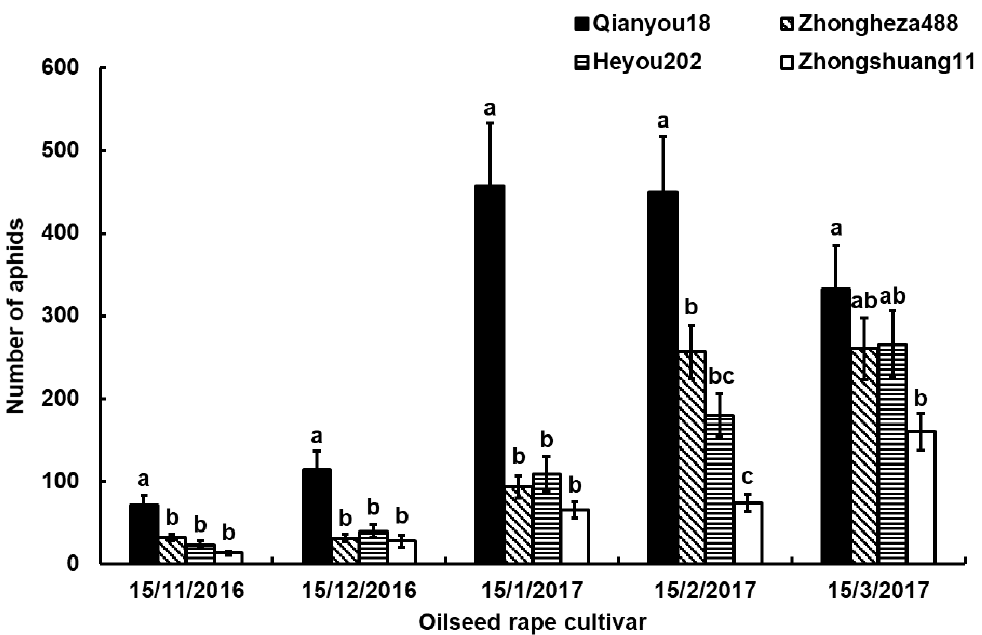
Figure 1. The dynamics of cabbage aphids on four oilseed rape cultivars in a greenhouse. Values are means ± standard error of mean(SEM) of the number of aphids (adults and nymphs). Data were analyzed by analysis of variance (ANOVA) followed by the unrestricted least significant differences (LSD) test. The significance level was set at P < 0.05. Bars represent stand error (SE). The same lowercase letters above columns at the same investigation time represent no significant differences among the cultivars.